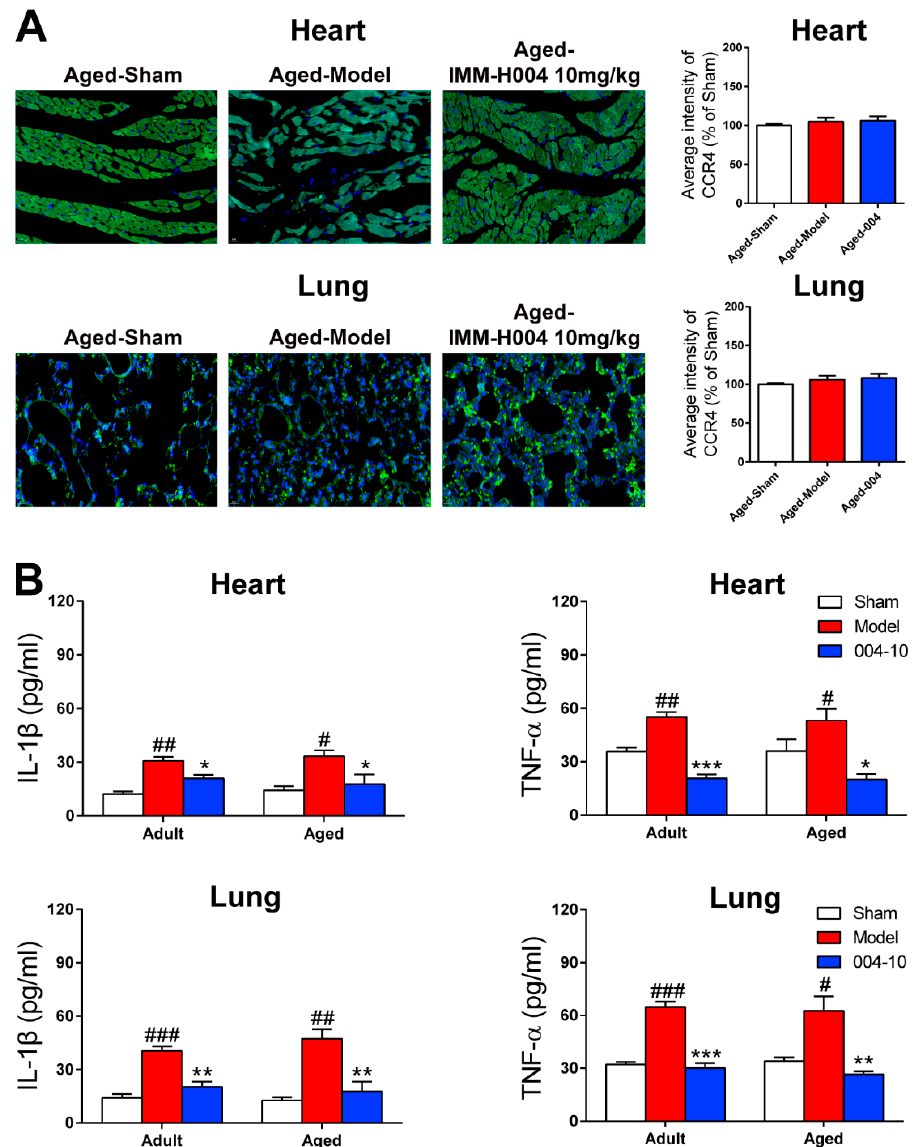
Figure 10. IMM-H004 decreases inflammation in heart and lung of aged rats. ( A ) Expression of CCR4 in heart and lung subfield from aged rats by immunofluorescence staining (400 × magnification, scale bar: 50 µ m). ( B ) Effect of IMM-H004 on IL-1 β and TNF- α levels in aged rats heart and lung using IL-1 β and TNF- α assay kits. All the data are shown as the mean ± SD; part of data are shown as the mean ± SD after normalization to the sham ( n = 6/group). # p < 0.05 vs. sham; ## p < 0.01 vs. sham; ### p < 0.001 vs. sham; * p < 0.05 vs. model; ** p < 0.01 vs. model; *** p < 0.001 vs. model.